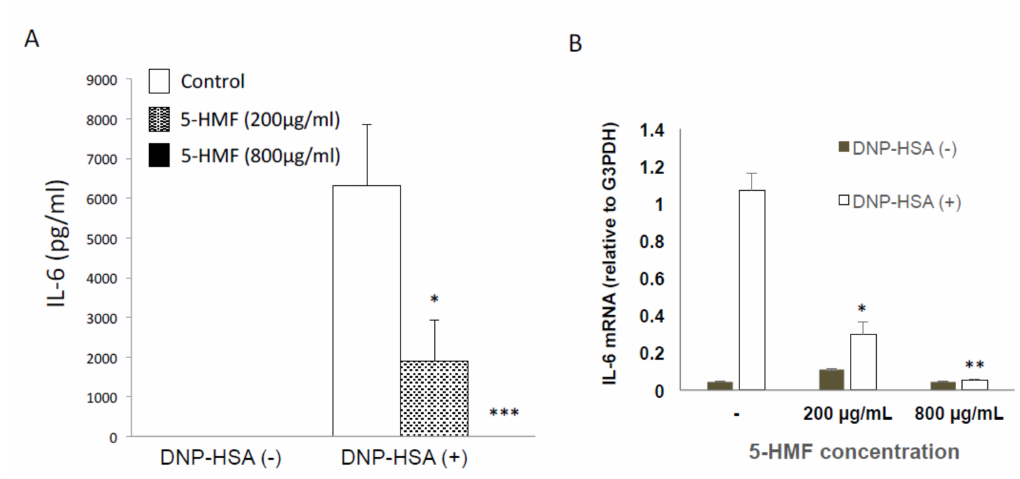
Figure 5. Inhibitory e ff ect of 5-HMF on cytokine production and gene induction in mast cells. ( A ) Mast cells were stimulated with 10 ng / mL DNP-HSA for 6 h and 5-HMF was added at the time of stimulation. IL-6 production was then measured by ELISA. Data are from a representative of at least three trials that showed similar results. Data are presented as mean (SD). * p < 0.05, *** p < 0.001, two-tailed Student’s t -test. ( B ) Expression of IL-6 mRNA relative to G3PDH mRNA. Mast cells were stimulated with 10 ng / mL DNP-HSA for 1 h in the presence of 200 or 800 µ g / mL 5-HMF. A representative of three experiments is shown. Error bars represent standard deviation among duplicate samples. * p < 0.05, ** p < 0.01, two-tailed Student’s t -test.